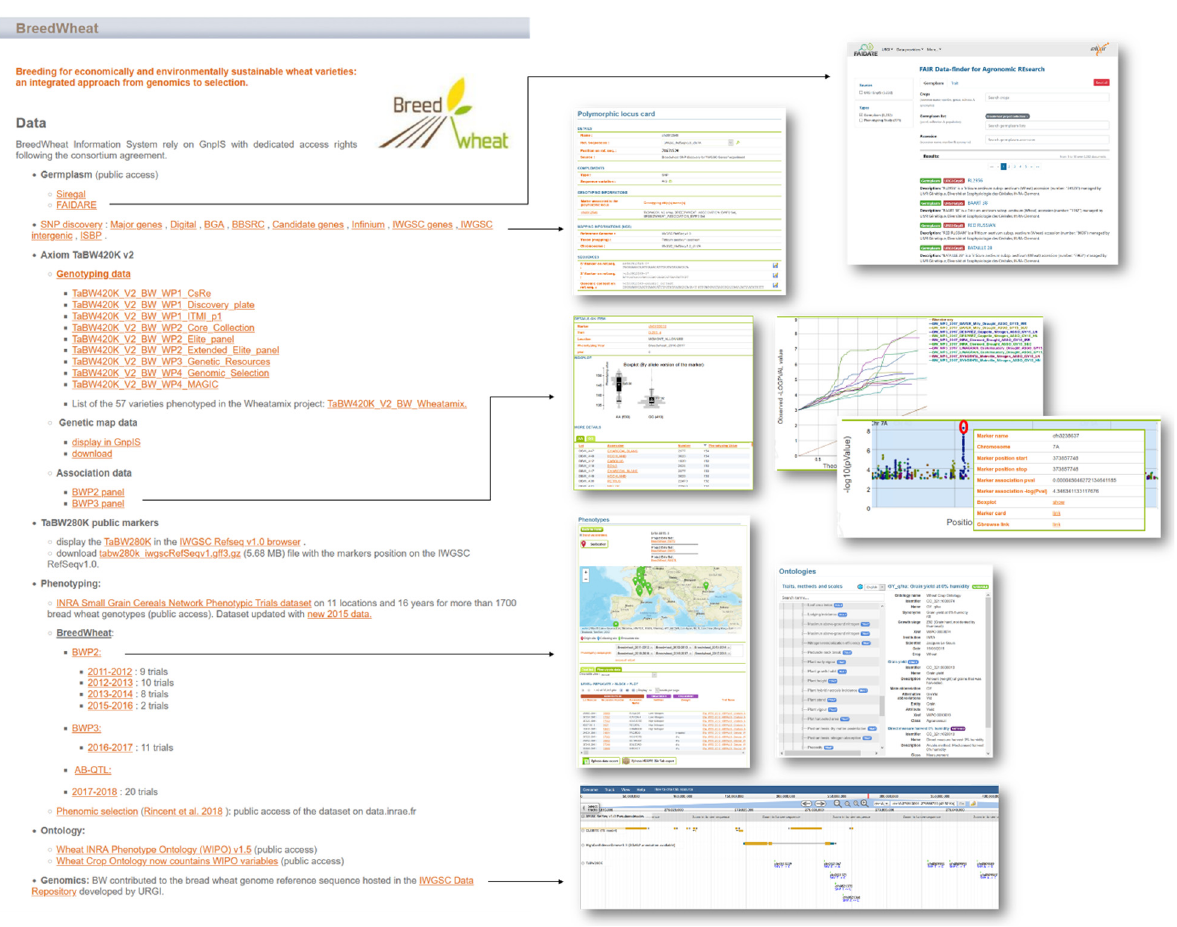
Figure 7. BREEDWHEAT data summary webpage (https://wheat-urgi.versailles.inrae.fr/Projects/BreedWheat (accessed on 16 December 2021)) with some examples of GnpIS web interface results.